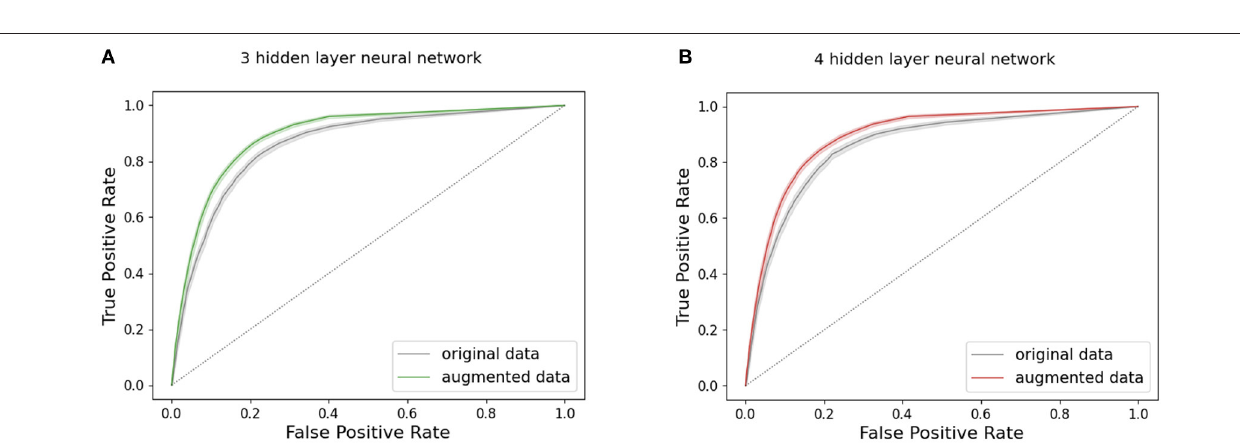
FIGURE 5 | Artificial neural network performance: ROC curves with 95% confidence interval for (A) 3 and (B) 4 hidden layer feedforward neural network, comparing models trained on augmented and baseline population. True positive rate = TP / ( TP + FN ), false positive rate = FP / ( FP + TN